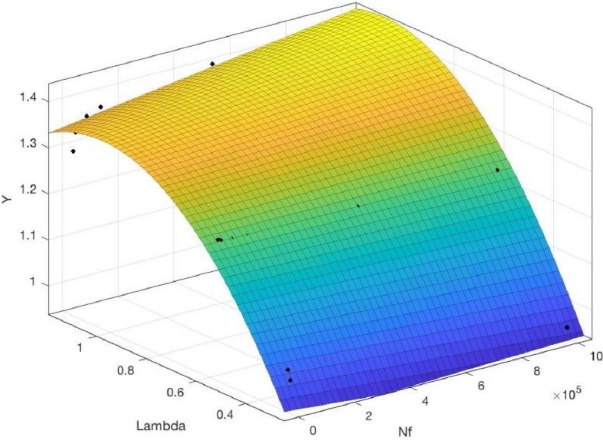
Figure 7. Regression surface for the Y normal as a function of λ and N f